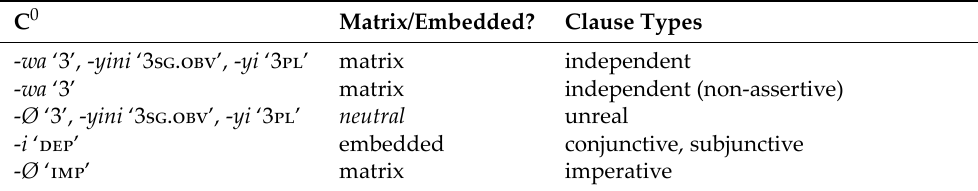
Table 2. Dependencies between C 0 and